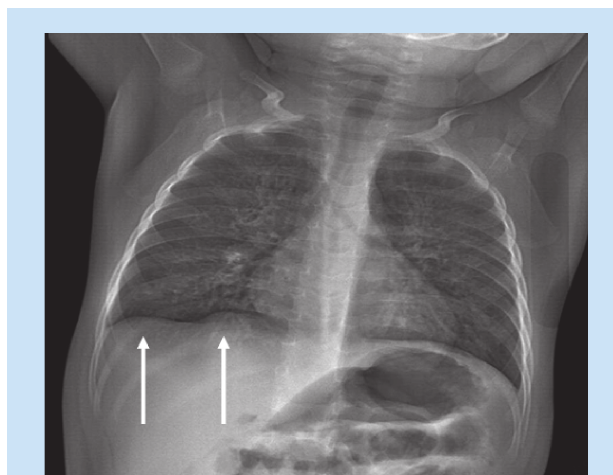
Fig. 3. Image showing the movement artefact involving the hemidiaphragm, indicated by the